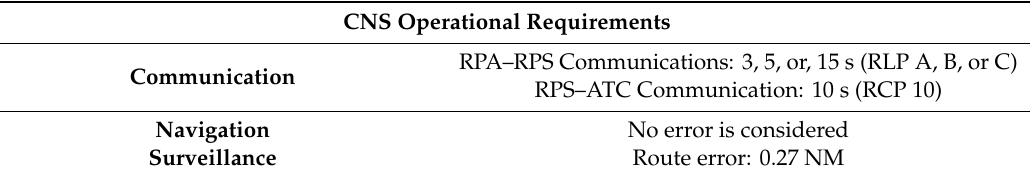
Table 3. Summary of communication, navigation, and surveillance (CNS) operational